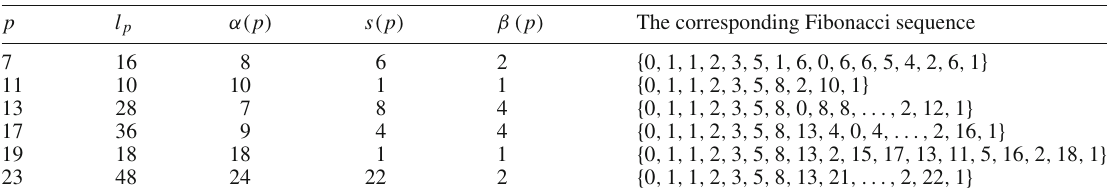
Table 1 The table indicates the connection between Pisano period ( l p ) , the index of the first term of the Fibonacci sequence which is zero (α ( p )) , the least residue of sequence ( s ( p )) , and the number of zeros in a single period of Fibonacci sequence computed in F p (or equivalently the order of s ( p ),(β ( p )) modulo prime p